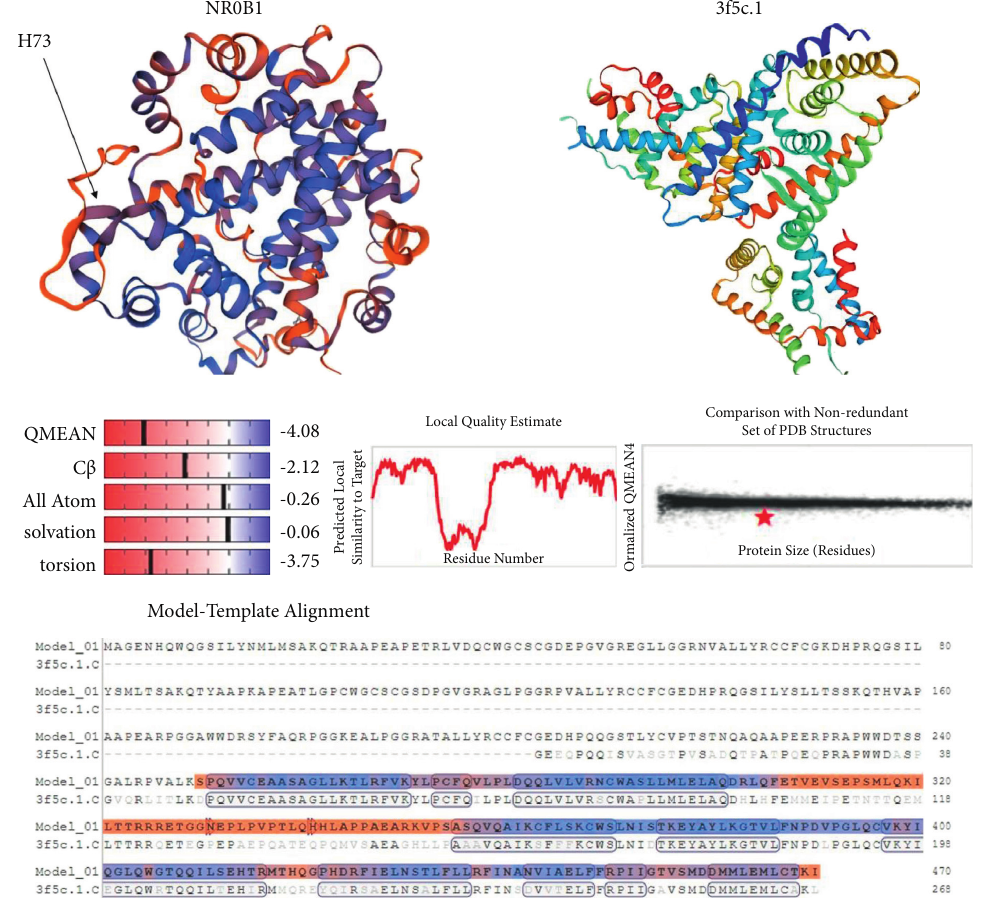
Figure 2: The SWISS-MODEL templates library (3f5c.1) and homology modeling of